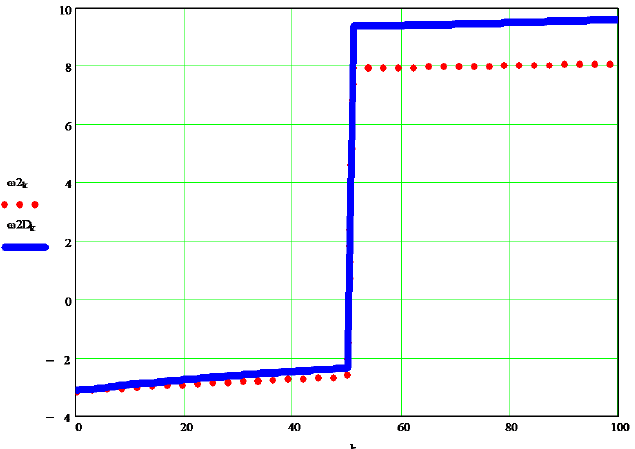
Figure 17. The dynamic angular speed of element 2 of the articulated robot, compared to the input (kinematics) considered speed (to a 6R2T robot).